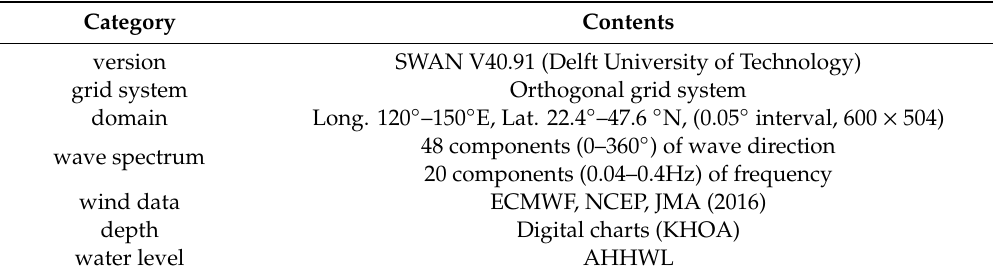
Figure 3. Comparison of wave parameters (wave height, period, and direction) among the three different wave bands at KMA-2 location. Case 1: 20 bands in (0.04–0.4)-Hz frequency range; Case 2: 40 bands in (0.04–0.4)-Hz frequency range; Case 3: 40 bands in (0.02–0.4)-Hz frequency range. Table 3. Numerical wave model (SWAN)